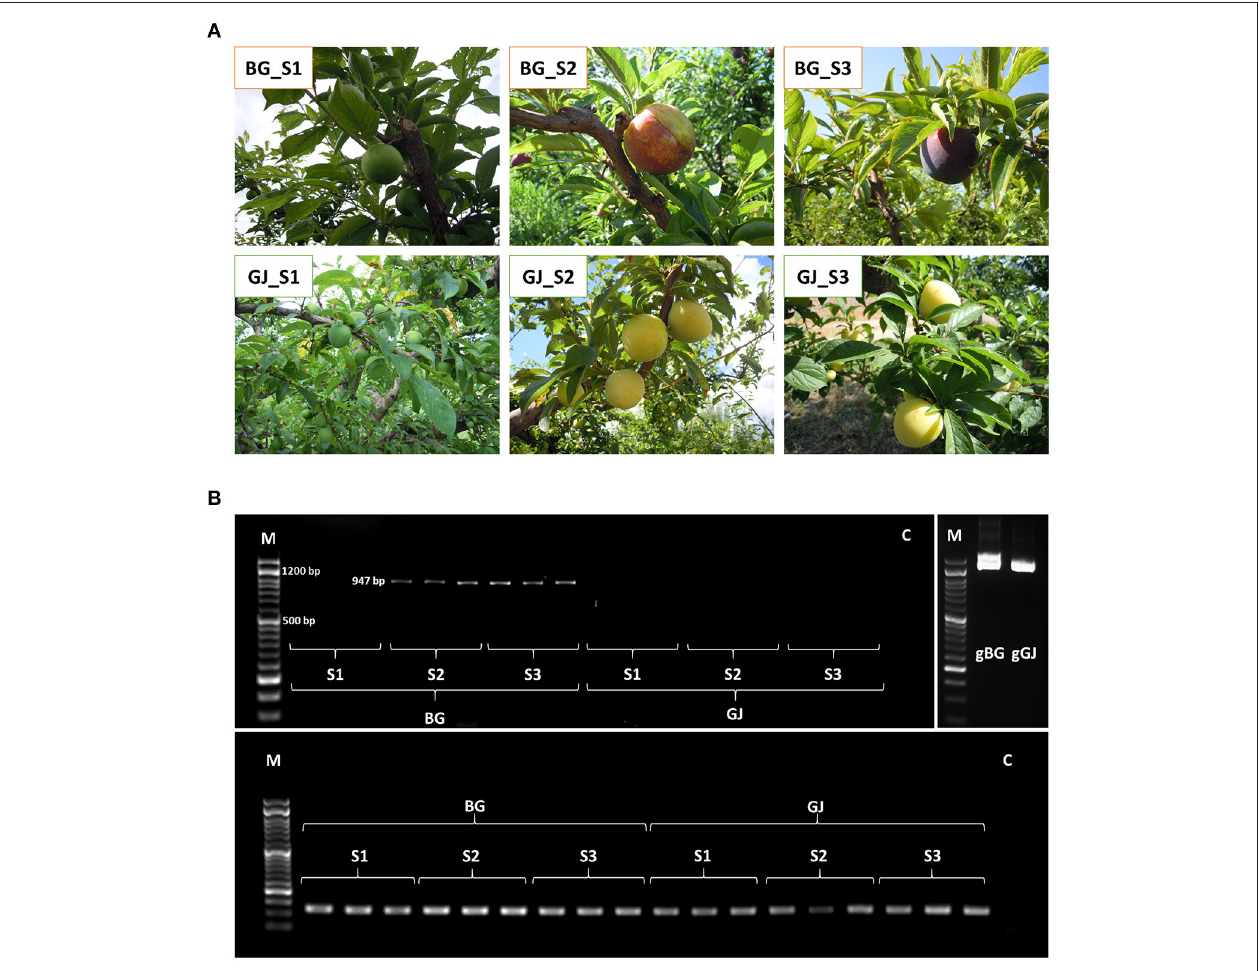
FIGURE 6 | (A) RNA was extracted from the skin of Black Gold (BG) and Golden Japan (GJ) at three maturation stages (S1, S2, and S3). (B) Top row left: PsMYB10.1 amplification from complementary DNA (cDNA) samples (BG_S2 and BG_S3). Band size 947 bp; top row right: PsMYB10.1 amplification of genomic DNA (BG and gGJ). Band size 1.5kb; bottom row: expression of the MON reference gene in all cDNA samples tested. Well M: DNA Ladder 50 bp ready-to-use (GeneON); well C: no template